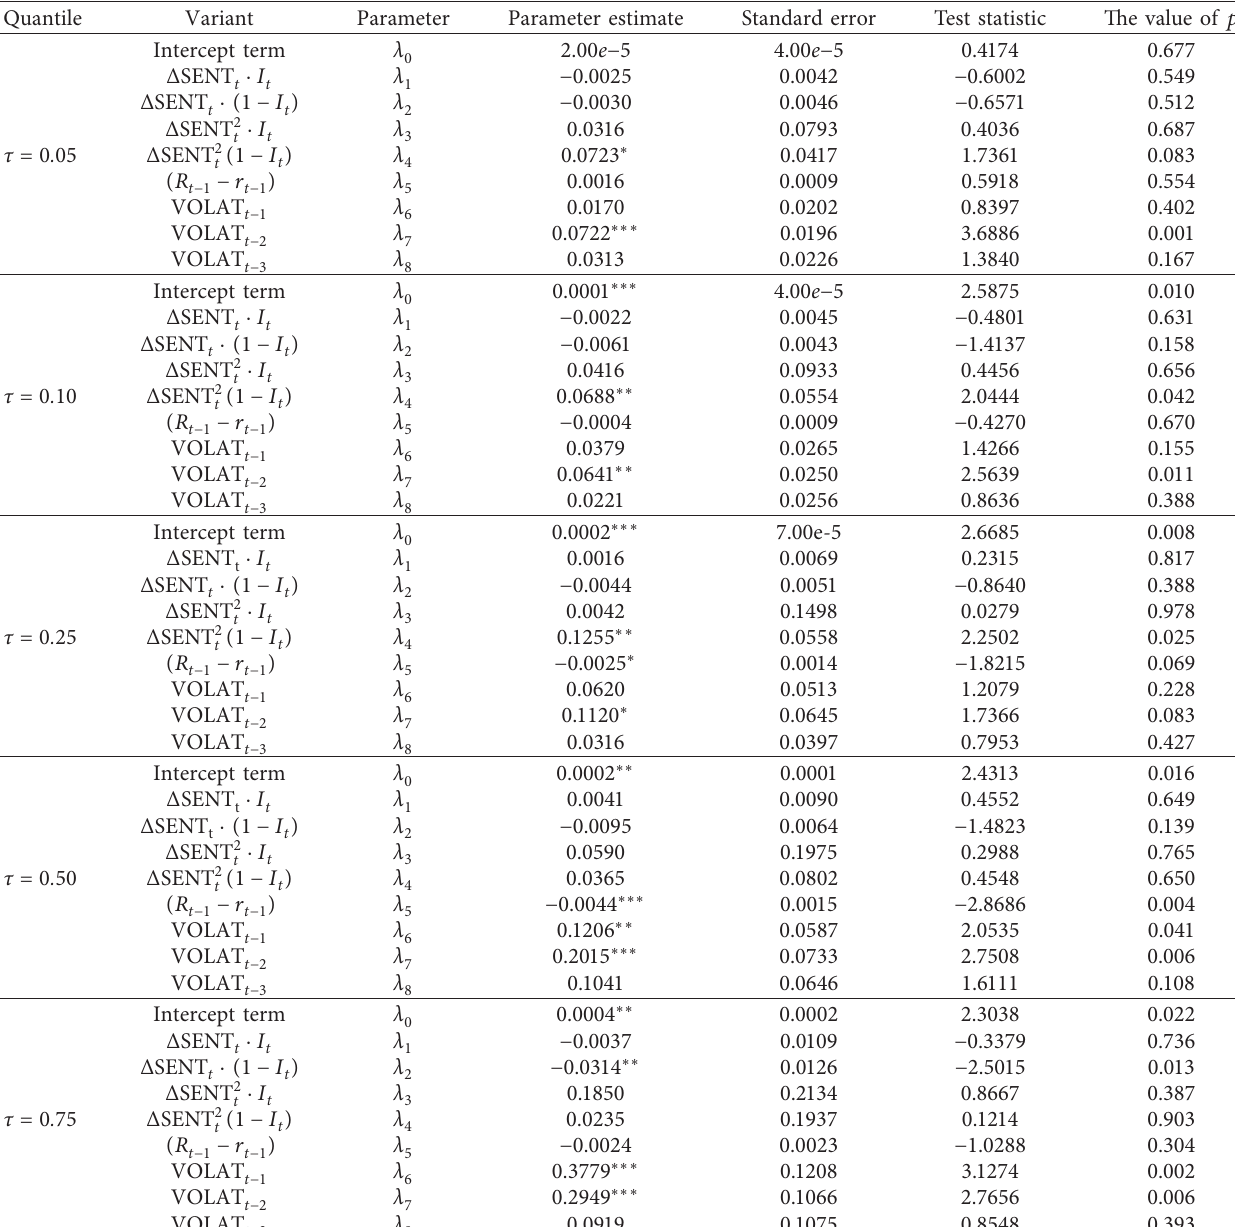
Table 5: Quantile regression results of